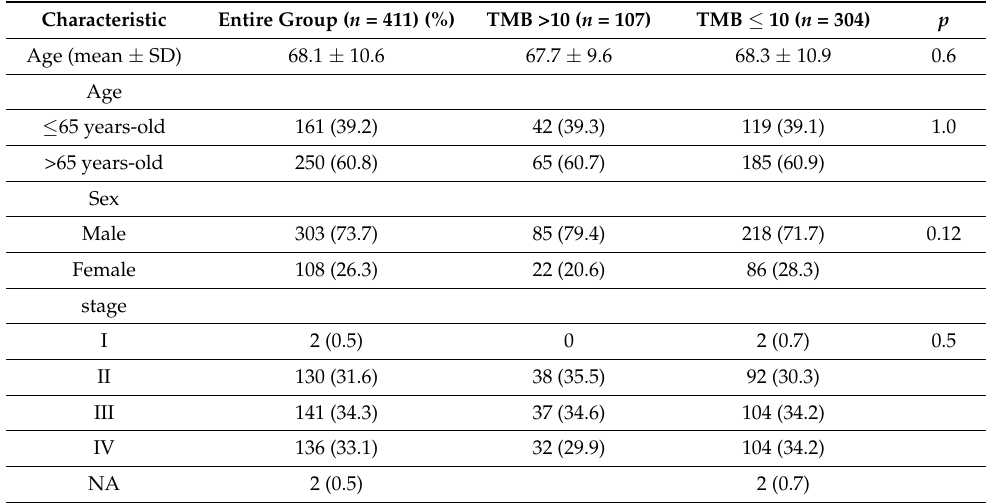
Table 1. Characteristics of patients in the whole TCGA cohort of urothelial bladder carcinoma and according to the TMB groups. NA: Not